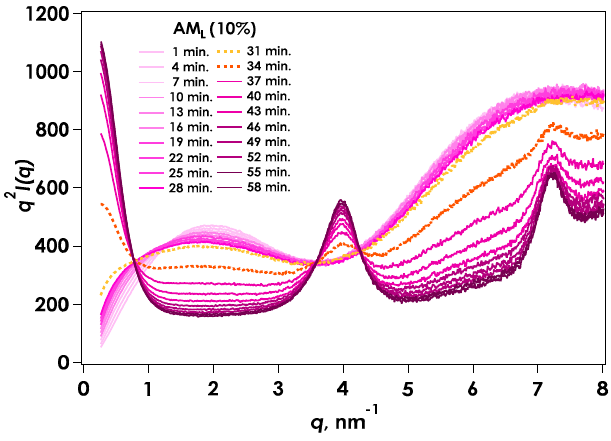
Figure 4. Time variation of Kratky plots for time-resolved SAXS for gelation of AM L by in situ neutralization.